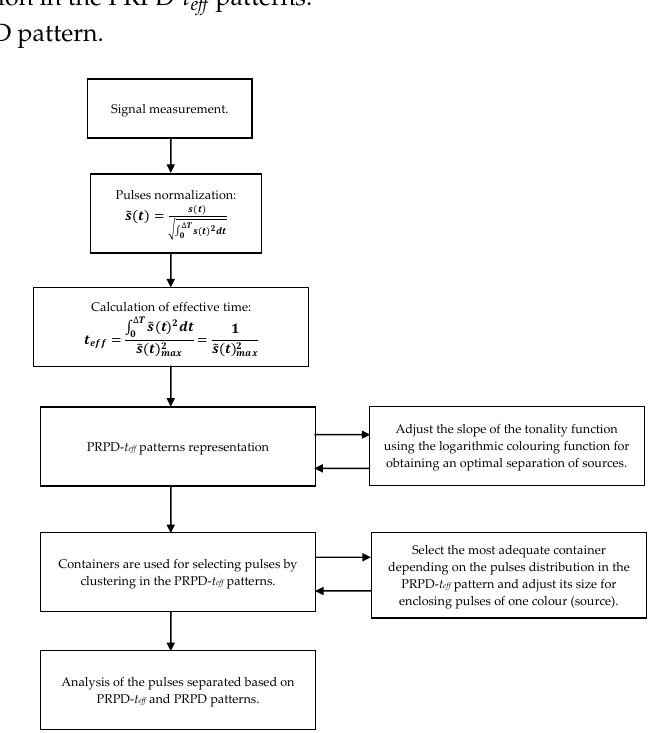
Figure 1. Flowchart used for separating PD sources using the PRPD- t eff concept.